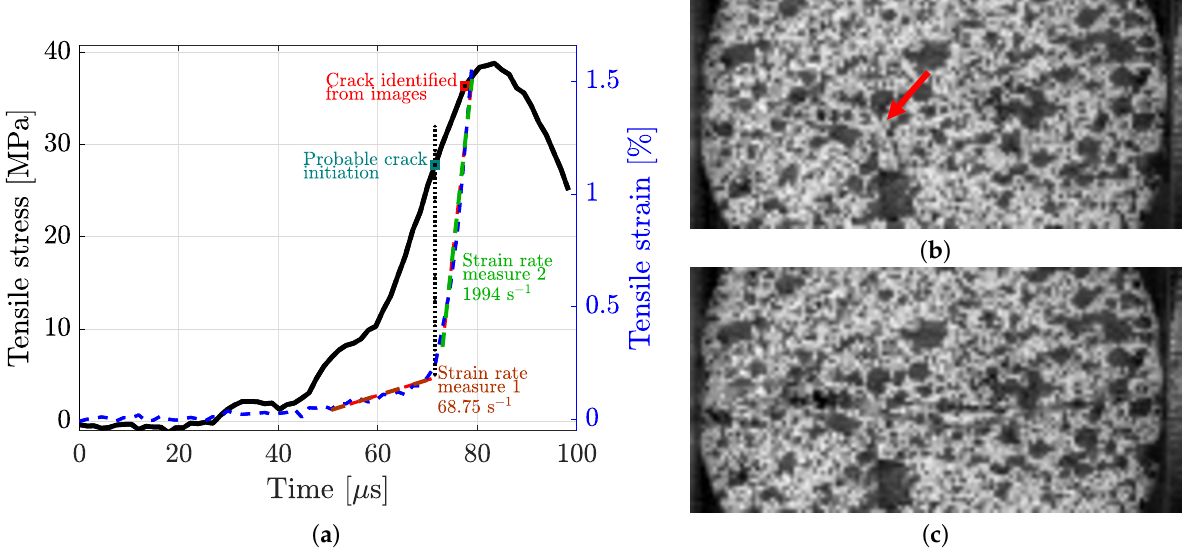
Figure 8. An example of the time evolution of indirect tensile stress and strain from a Brazilian disc test of granite ( a ), the instant of observed crack initiation ( b ) and the fully propagated crack ( c ). The resolution of the high-speed images ( b , c ) is 128 × 64 pixels or 26.0 × 13.0